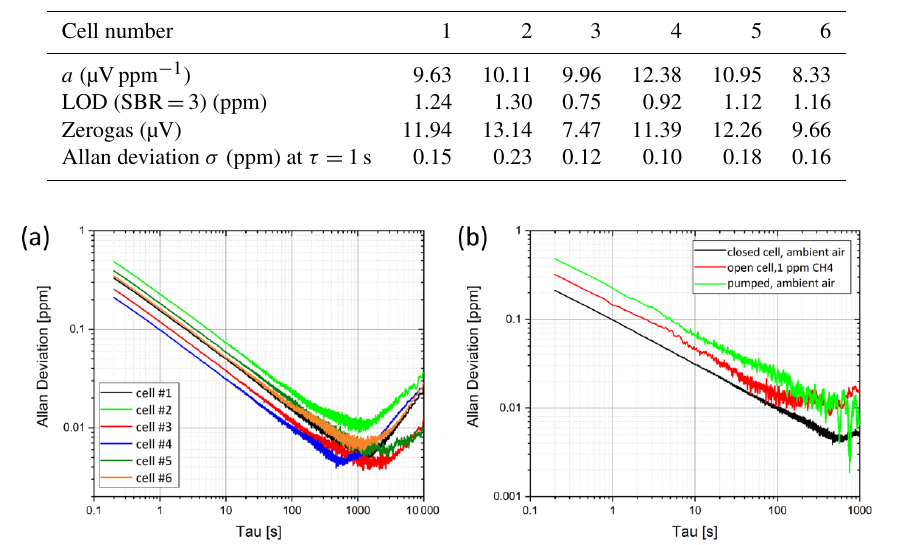
Figure 5. (a) Allan deviation of all cells for ambient air, cells closed. (b) Allan deviation for different flow conditions in cell 4: at a flow rate of 300mLmin − 1 and a methane concentration of 1ppm, with ambient air pumped through the cell, and while the cell containing ambient air was closed. All measurements at laser beam position ( x,y ) =